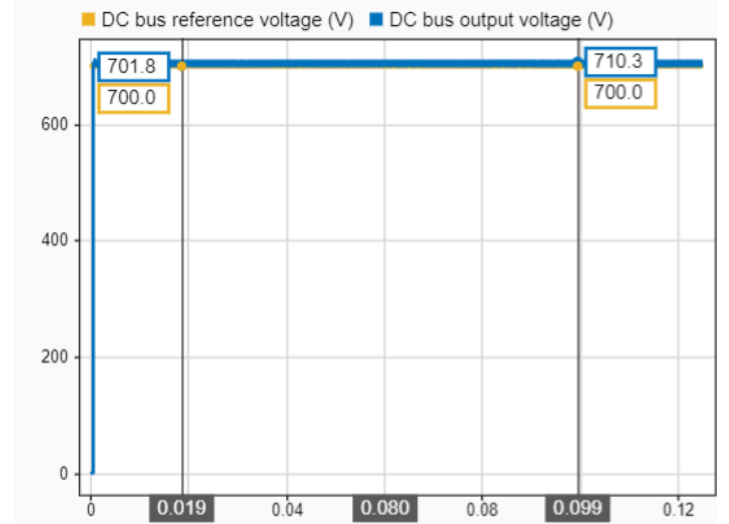
Figure 7. Output voltage using MPC under optimal TrgPS operation.